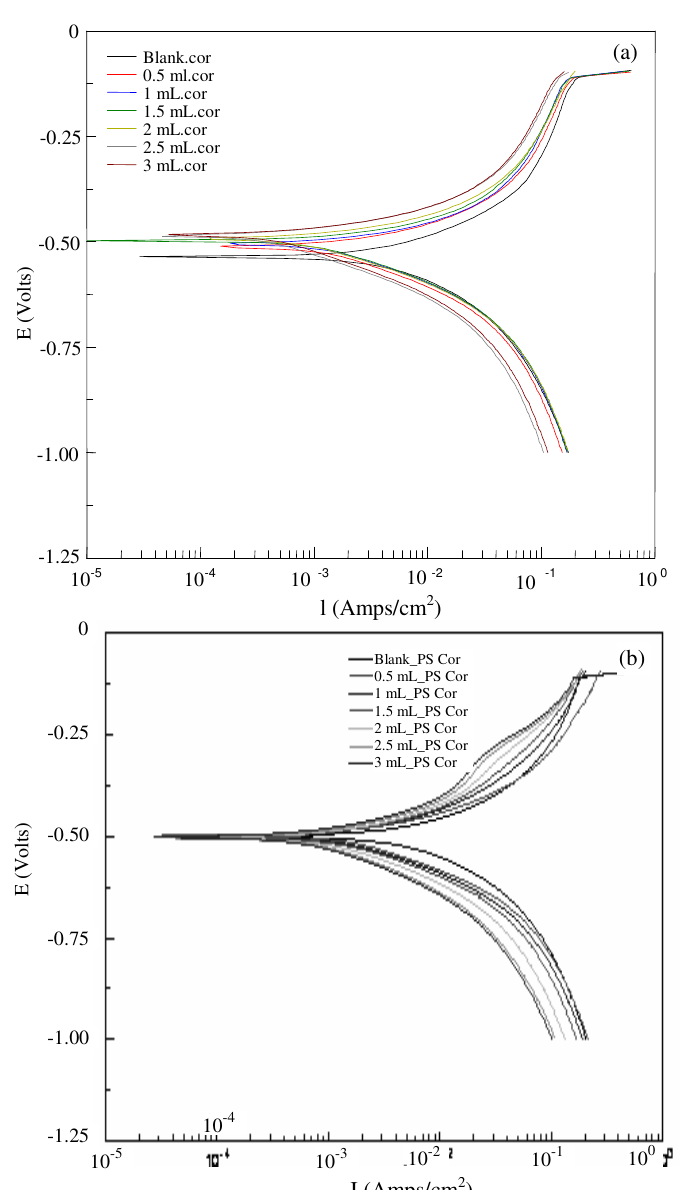
Figure 3. Polarization curve of mild steel in presence of palmyra palm shell extract in (a) 0.5 M H SO and (b) 1 M 2 4